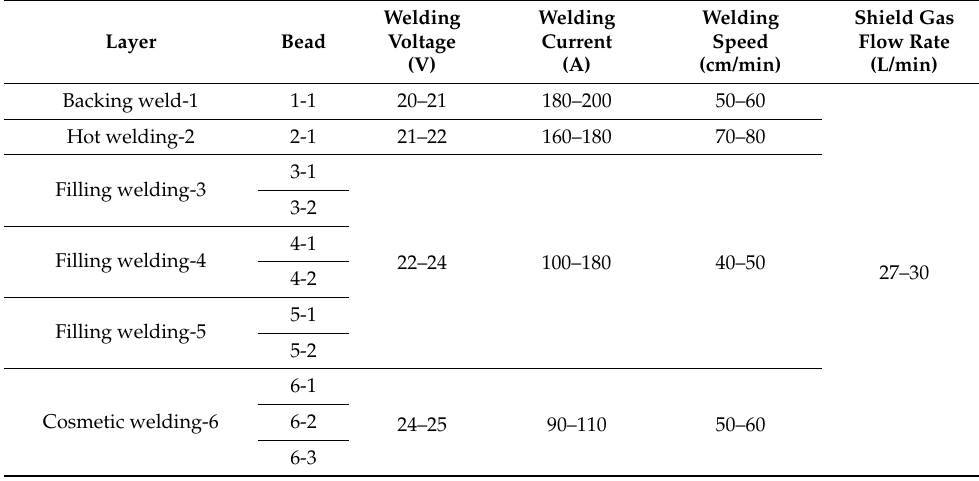
Table 1. The details of welding parameters for each weld layer of X80 joint.